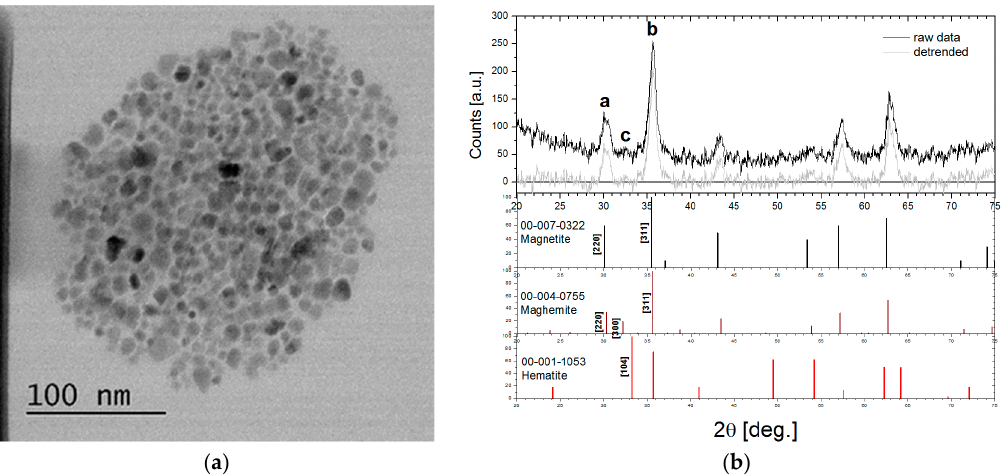
Figure 4. ( a ) TEM image of the MIONPs, ( b ) XRD spectrum of the MIONPs and magnetite, maghemite, and hematite PDFs.